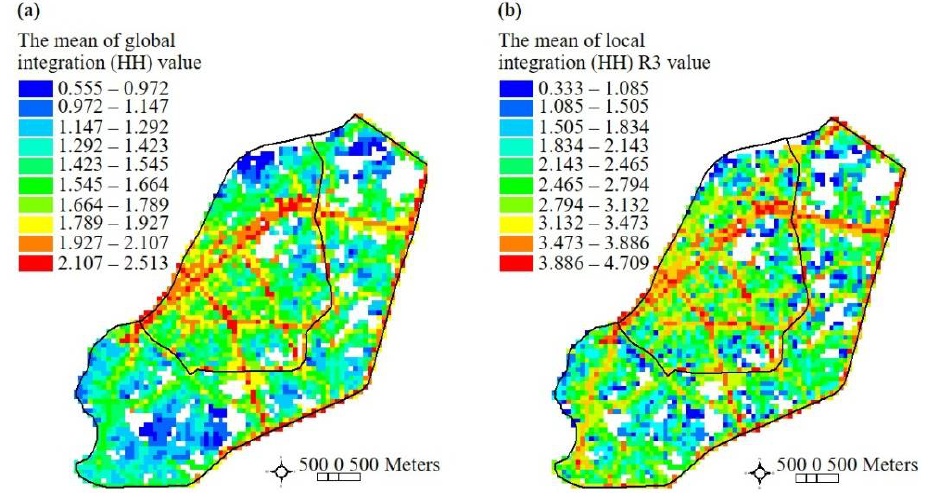
Figure 8. Gridded maps of the mean of ( a ) global integration ( HH ) value and ( b ) local integration ( HH ) R3 value .